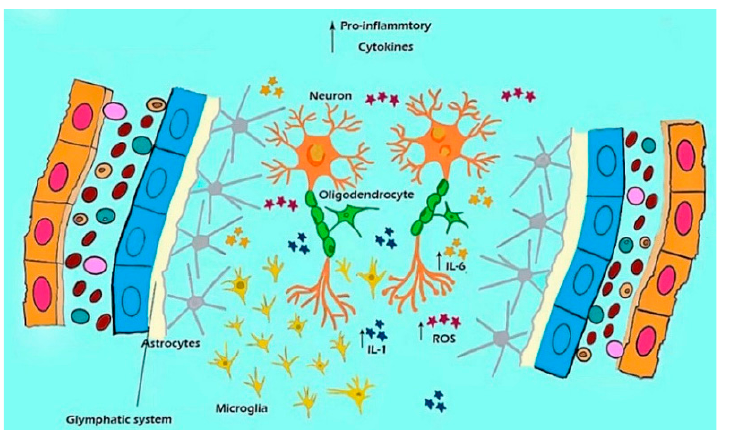
Figure 4. A model shows the contribution of microglial to the dysfunction of the glymphatic system, inducing ROS accumulation and inflammation in MDD. ROS accumulation and neuro-inflamma- tion are the major reasons for